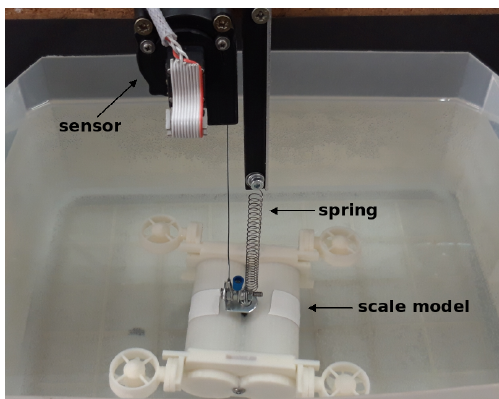
Figure 5. The scheme used for the free decay test, where y is the length displacement of the model when it is oscillating and K is the spring constant. The sensor is a linear encoder, from which the information is sent to the Arduino, which records the data using the ROS framework. Afterward, the information is processed using the Matlab software.